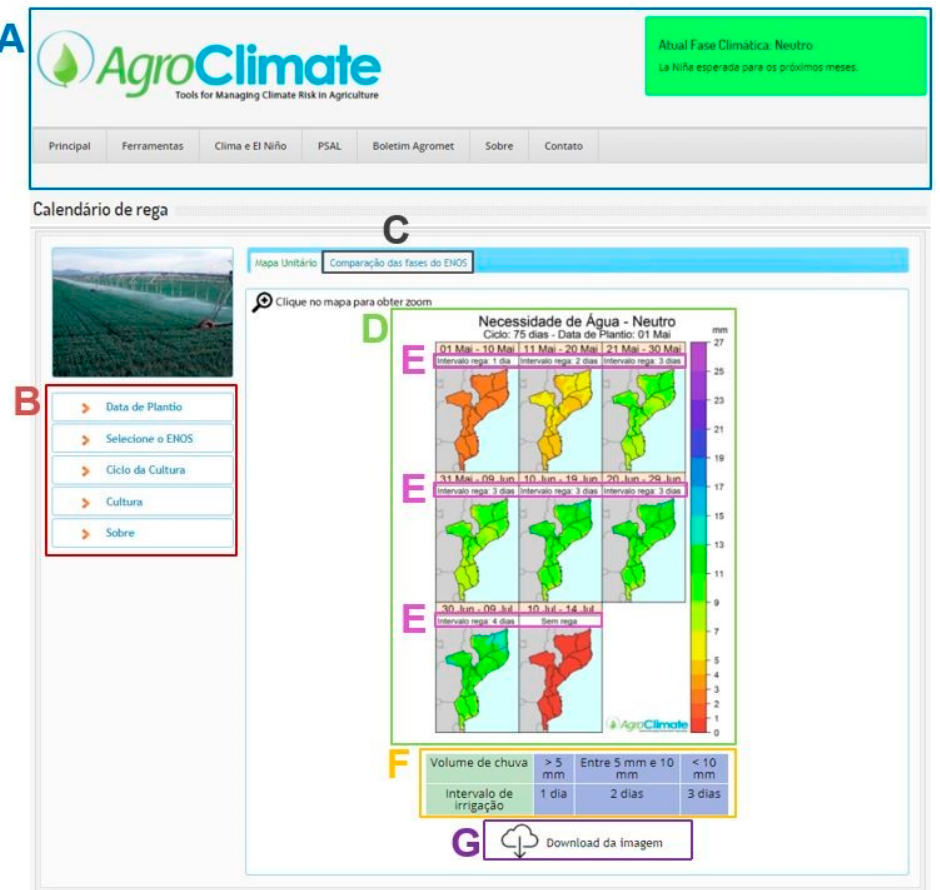
Figure 3. Screenshot of the irrigation scheduling tool in AgroClimate Mozambique (http://mz.agroclimate.org/rega). It shows the daily average water requirement for 90-day cycle tomato crops planted on May 1st. A shows information about the AgroClimate Mozambique website, the current ENSO phase, and the menu bar; B allows the user to select the management options more similar to what is observed in the field; C shows the ENSO phases comparison; D is the irrigation depth for each 10-day period; E is the irrigation frequency; F indicates how rainfall events can affect the schedule and depending on the amount of rain, the irrigation might be delayed for one, two, or three days; and G allows the download of the images.